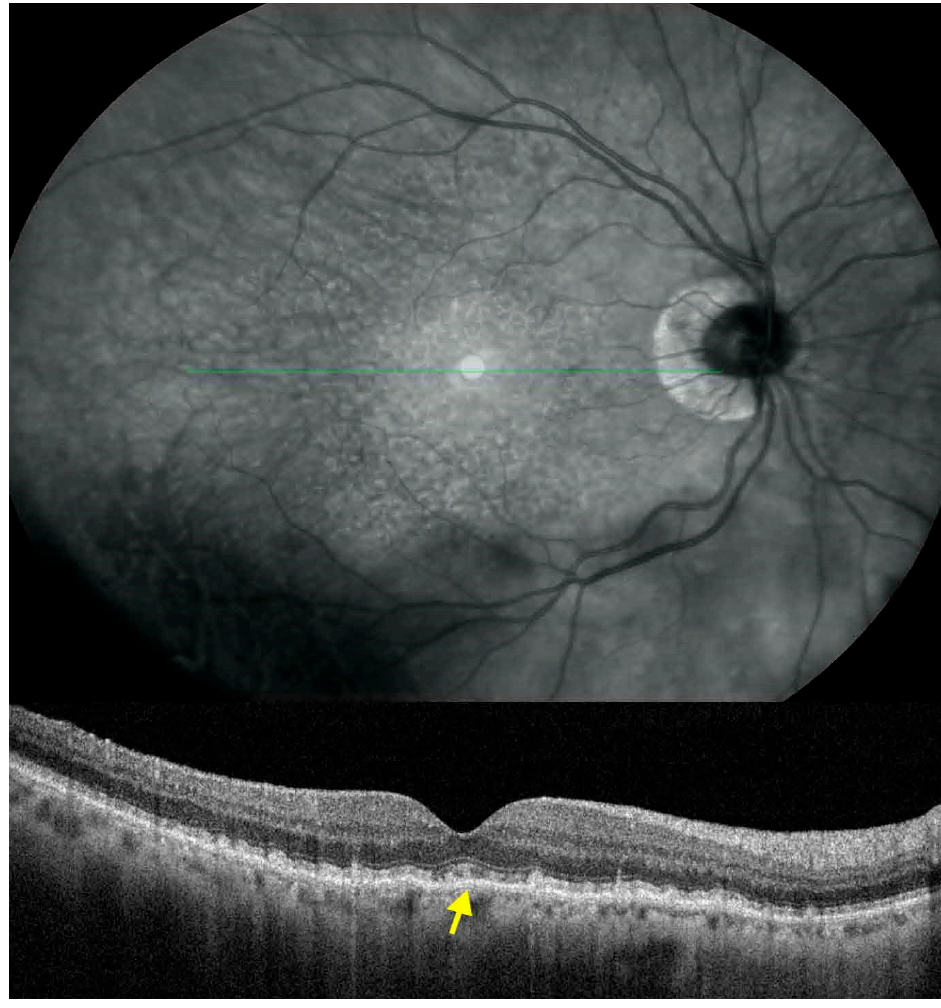
Figure 1. Spectral domain optical coherence tomography (SDOCT) scan of an eye with subfoveal subretinal drusenoid deposits (SDD). The SDOCT cross-sectional scan shows hyperreflective material between the retinal pigment epithelium and the ellipsoid zone with focal changes of the latter. SDD located under the fovea is shown with the arrow.